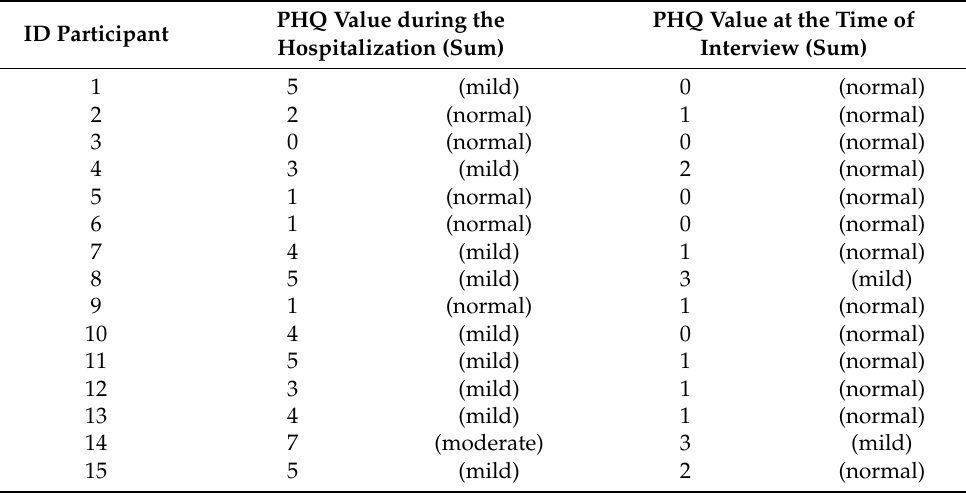
Table 5. Individuals’ score on mental health symptoms from